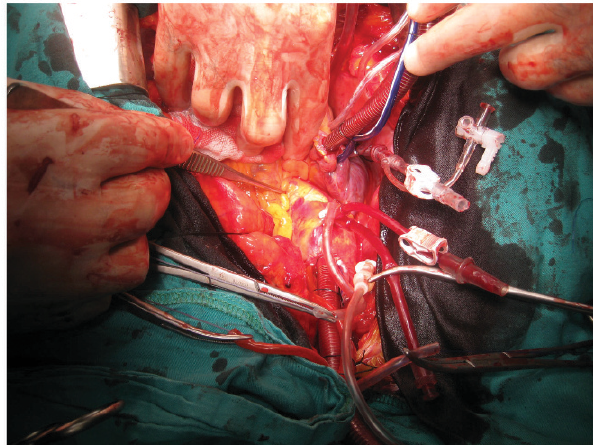
Figure 4 - During surgery, the right coronary artery ostium was